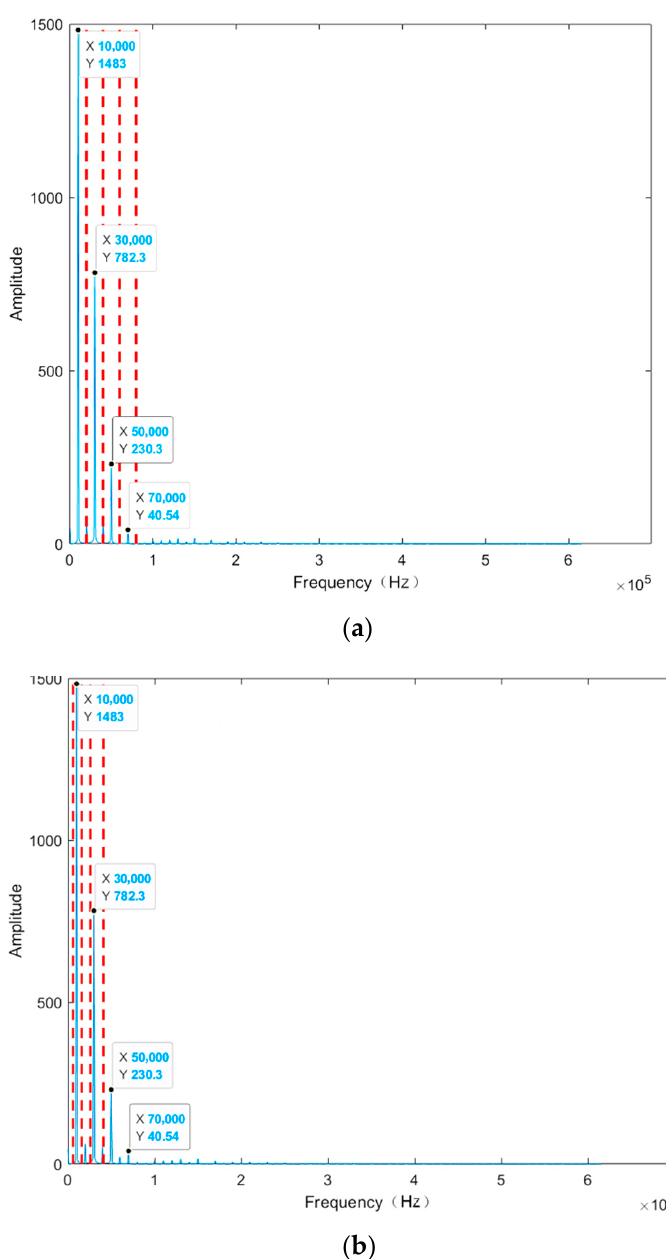
Figure 10. Spectrum segmentation result of the fault-free Sallen–Key bandpass filter circuit response: ( a ) spectrum segmentation based on the improved EWT; and ( b ) spectrum segmentation based on the traditional EWT.